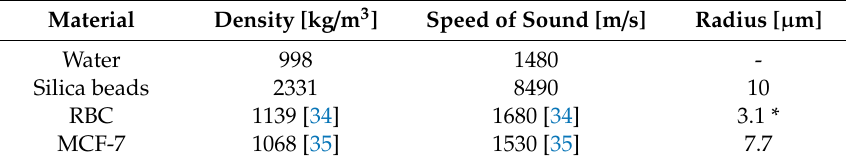
Table 1. Acoustic properties of the fluid and microparticles and